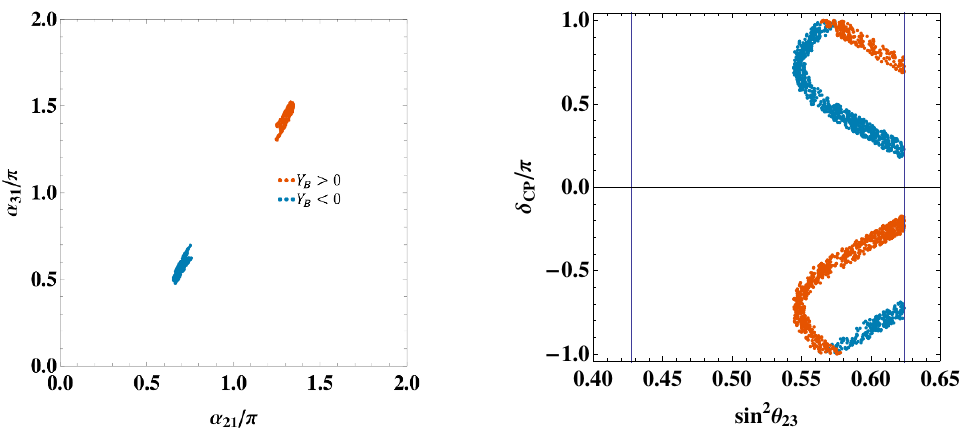
Figure 6 . (cid:11) 21 and (cid:11) 31 (left), and sin 2 (cid:18) 23 and (cid:14) CP (right). Y B is positive (negative) at the orange (blue) points.